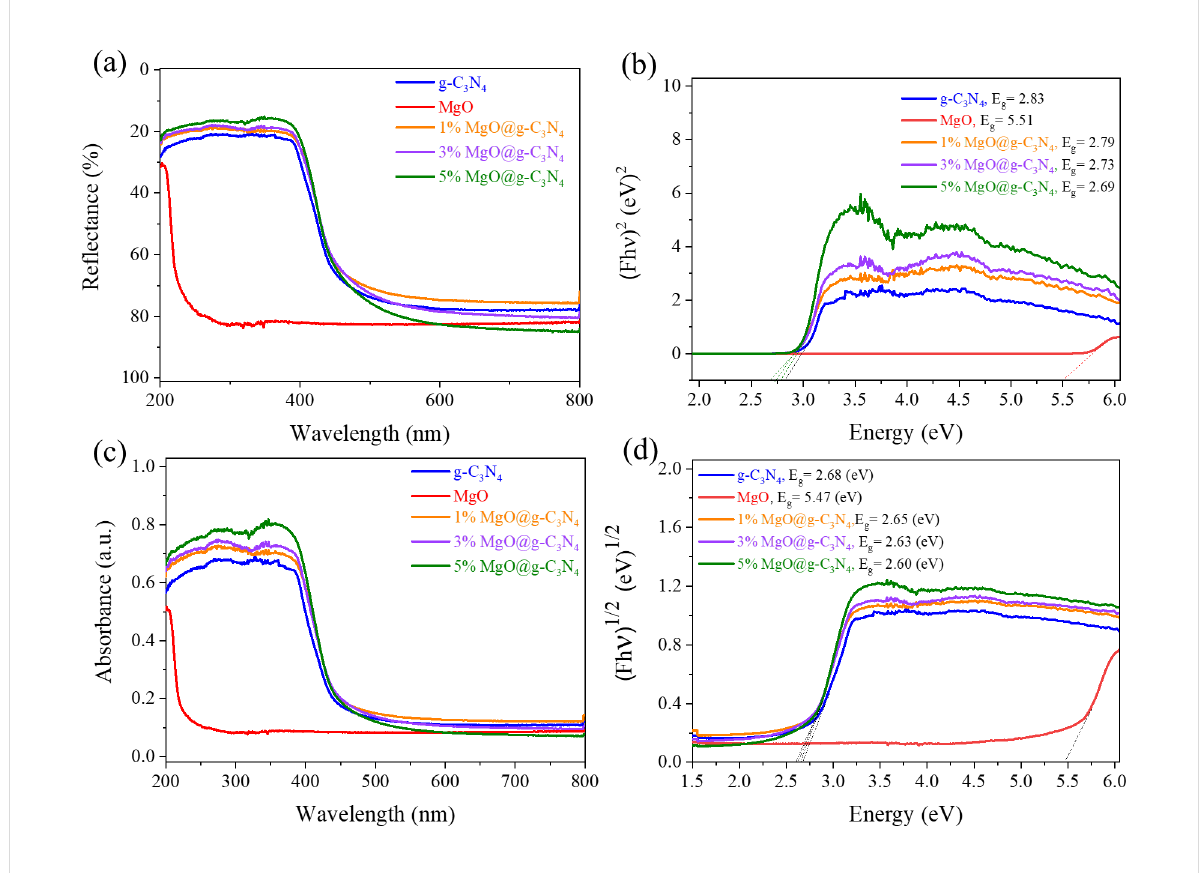
Figure 9: (a) DRS reflectance spectra, (b) direct bandgap, (c) DRS absorbance spectra, and (d) indirect bandgap of the